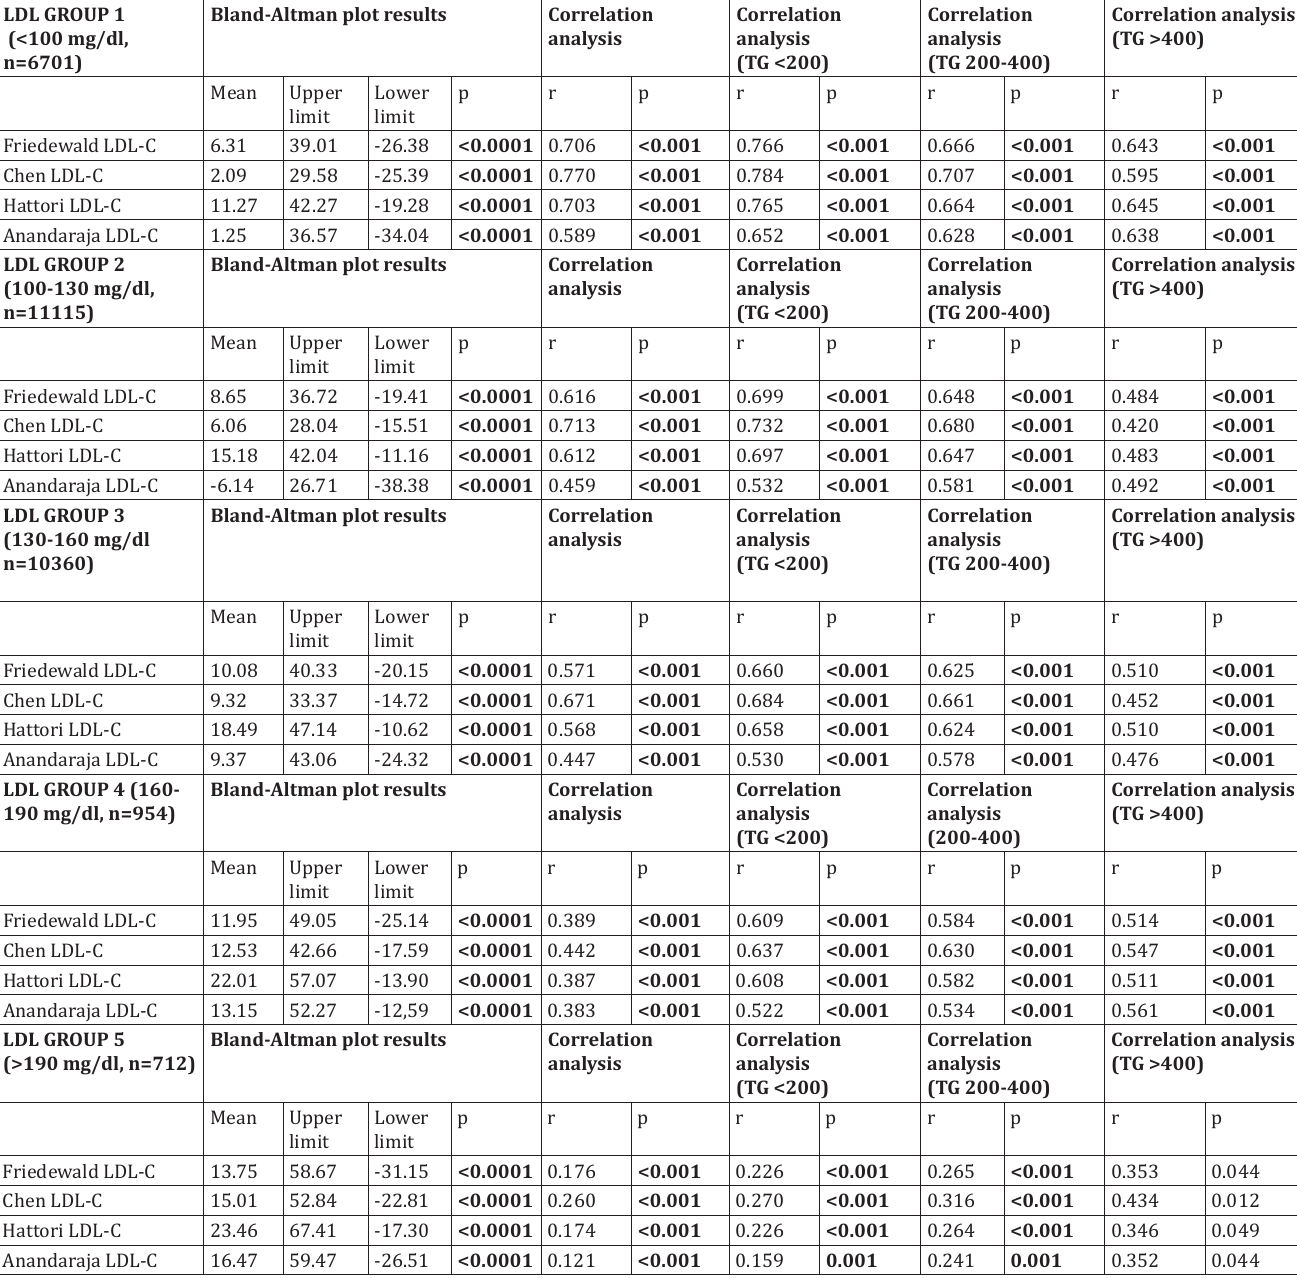
Correlation analysis and Bland-Altman plot results of LDL-C groups.